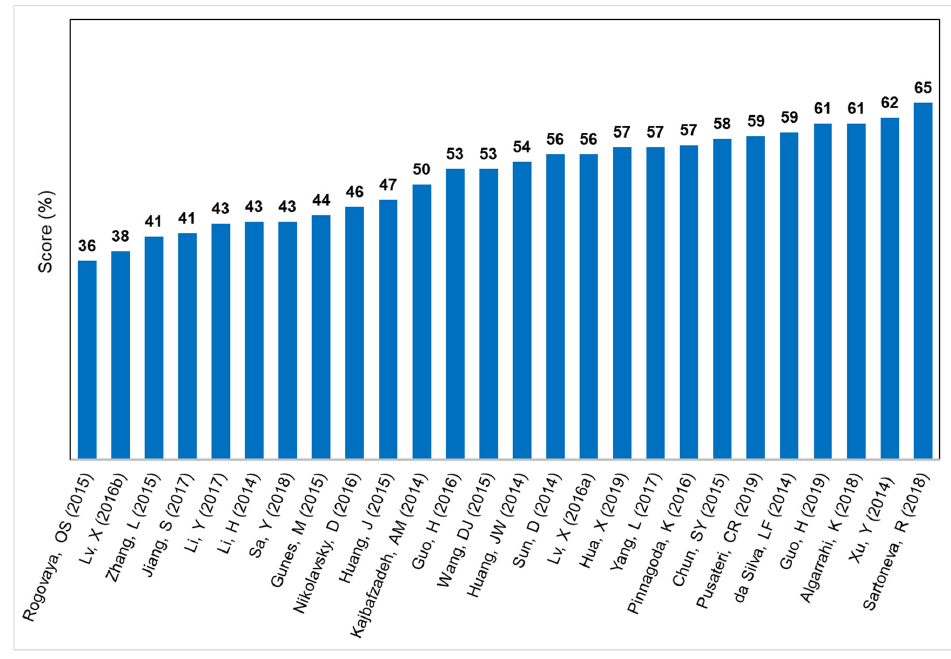
Figure 3. Bar chart displaying the scores of the analyzed articles. Scores represent the percentage adherence to the ARRIVE guidelines on a scale from 0 to 100.